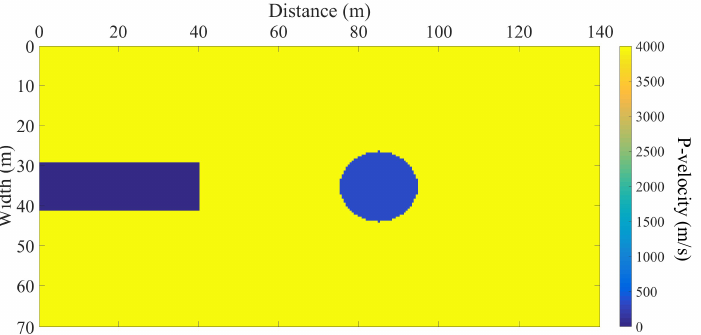
Figure 4. Karst cave model filled with